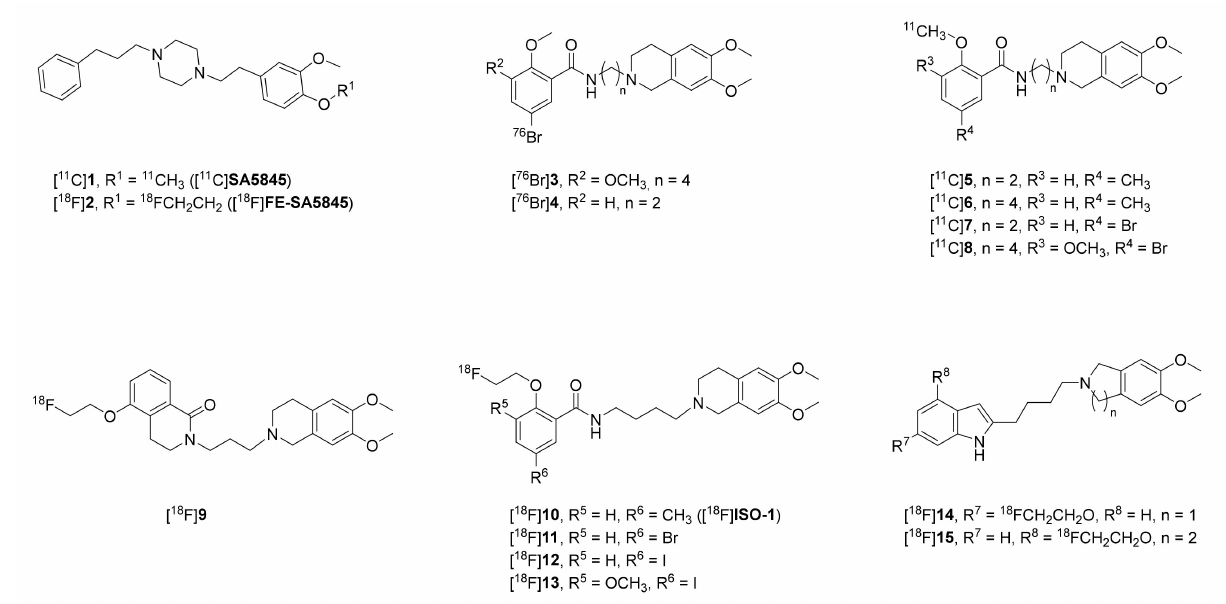
Figure 1. Representative σ 2 receptor